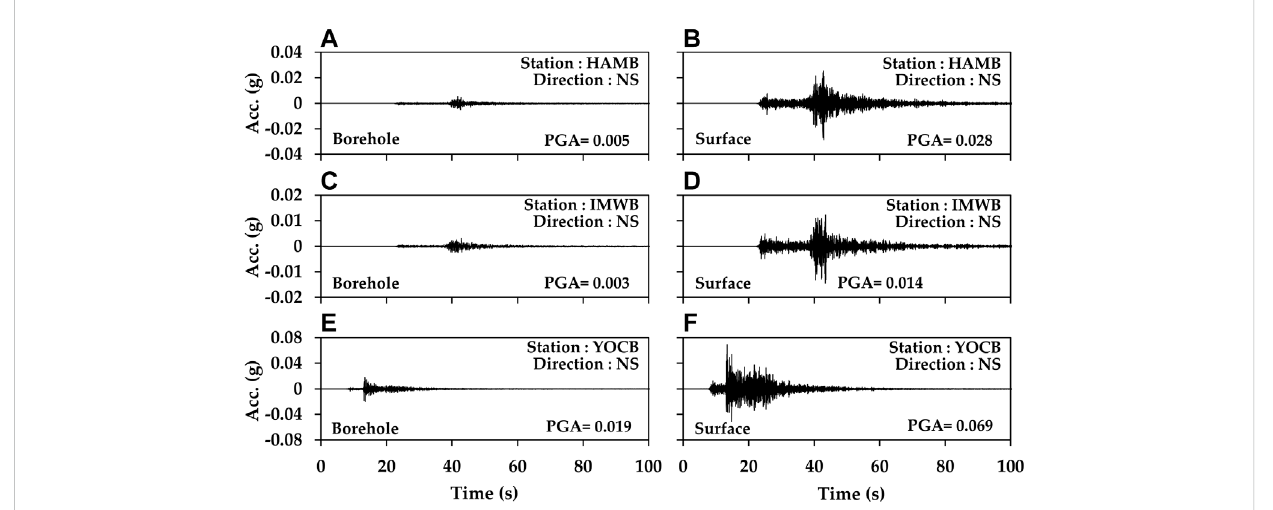
Seismic data for MKMA 5.8 earthquake occurring at 11:32:54 on 09/12/2016, recorded at HAMB station; and for MKMA 5.4 earthquake occurring at 05:29:31 on 15/11/2017 at IMWB station and YOCB station. (A,C,E) borehole and (B,D,F) surface records for NS channel of each station, respectively.